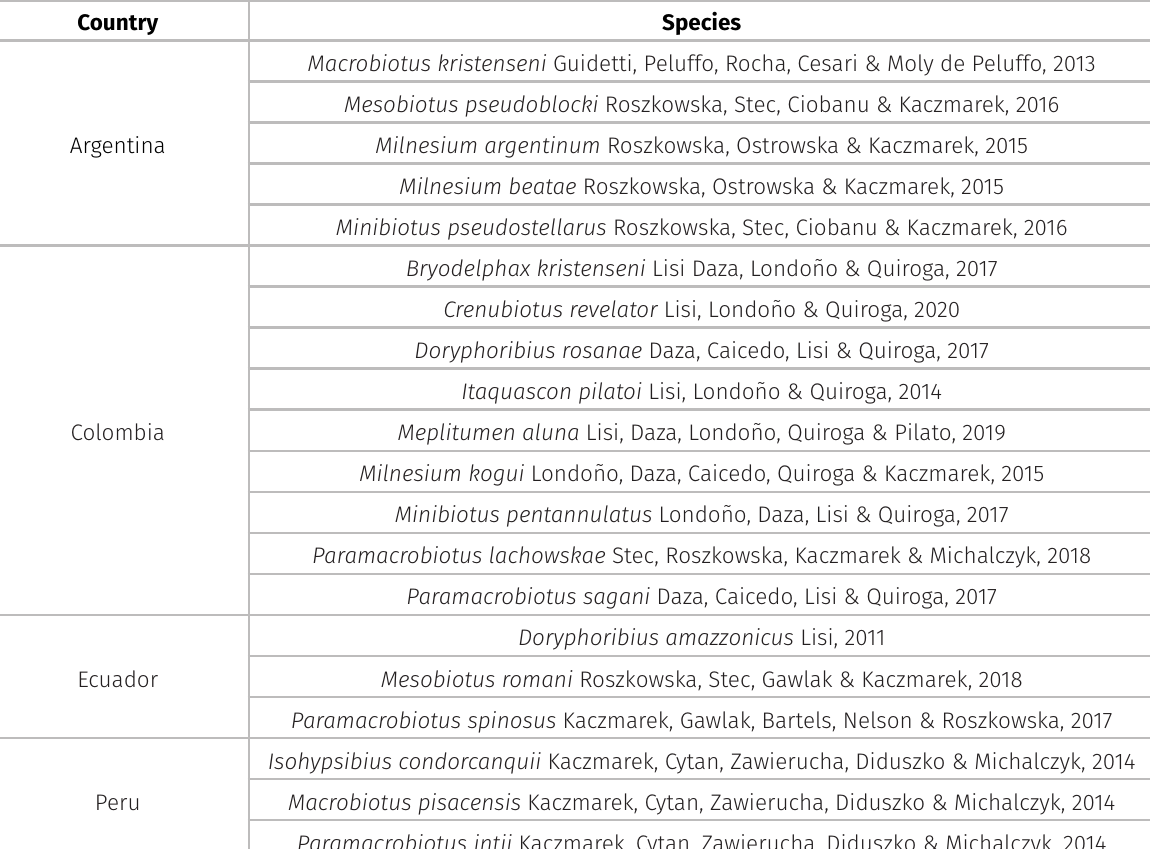
Table I. New limnoterrestrial tardigrade species described from South America in the last ten years.